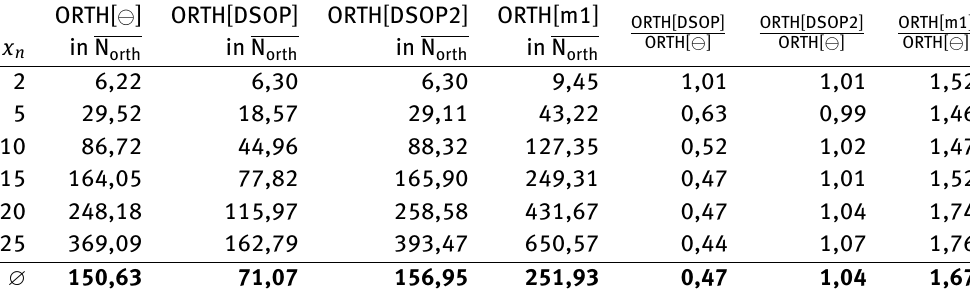
Table 3: Average of the number of terms N orth and relation to ORTH [ ⊖ ] ORTH [ ⊖